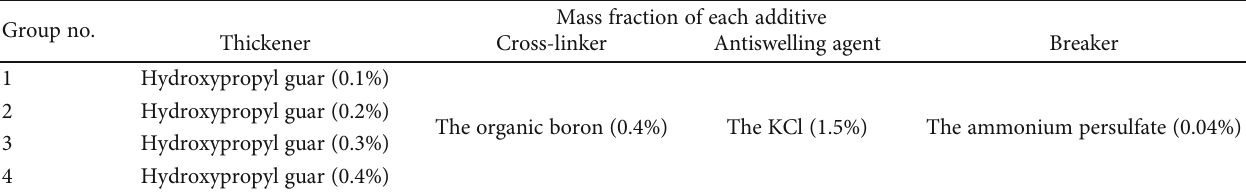
Table 1: The main components of each group of fracturing fl uids. Group